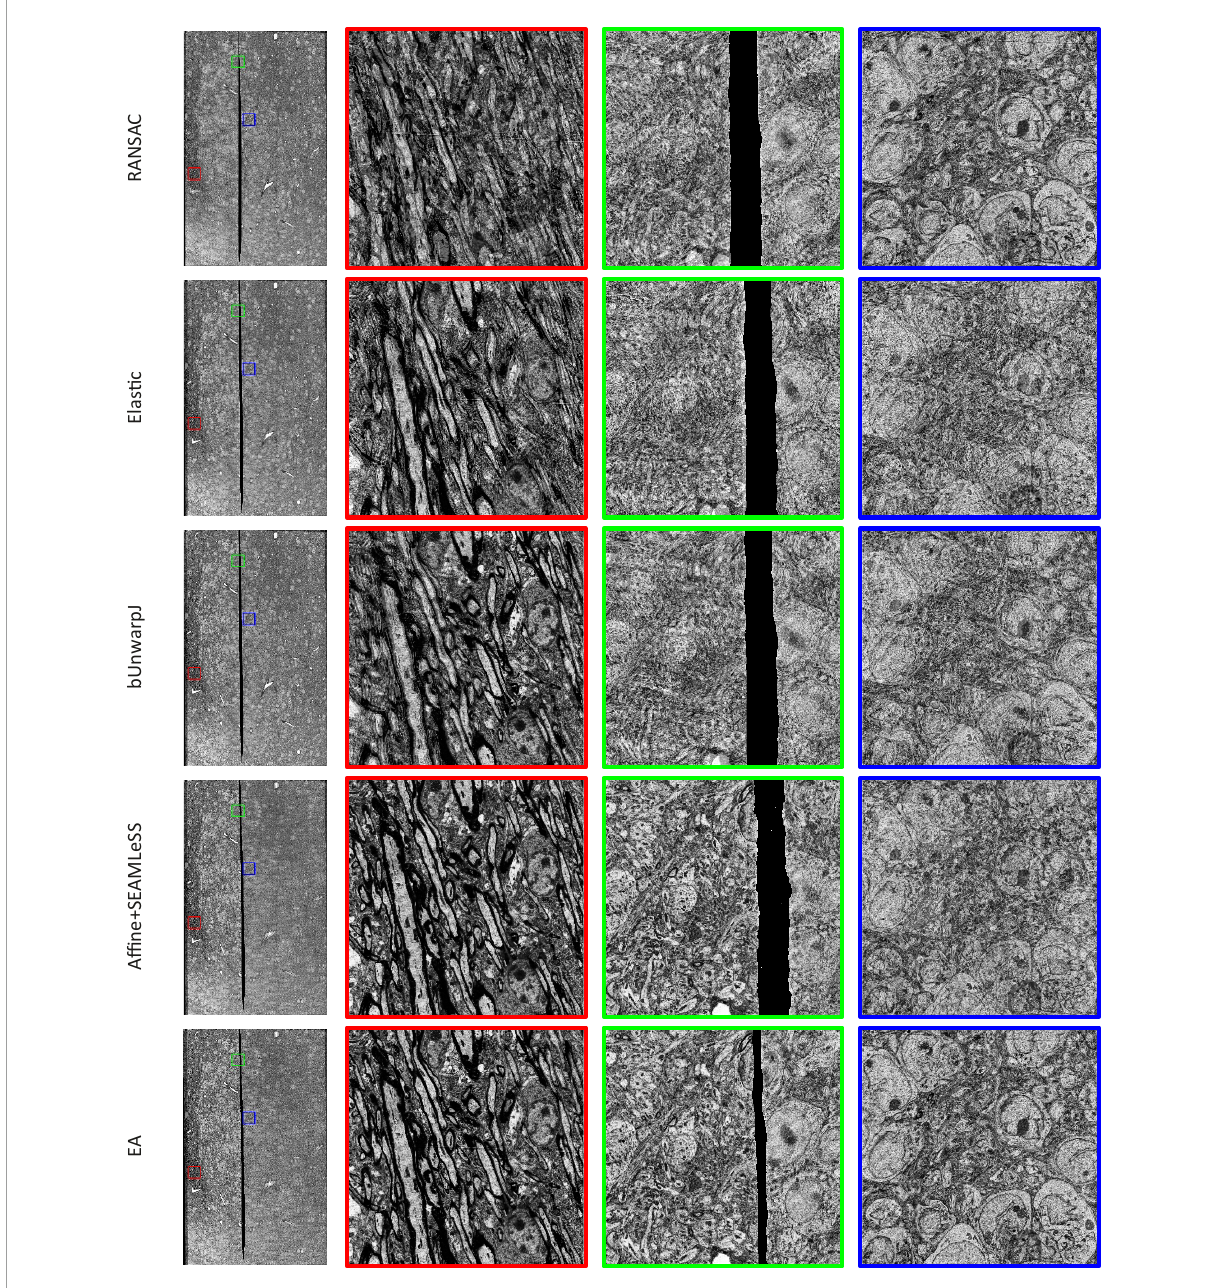
FIGURE4 The registration results of Crack Sample, which were generated by superimposing damaged sections and reference sections. A location with noticeable ghosting indicates that it is not registered well. The complete registration results can be obtained from the Supplementary Materials